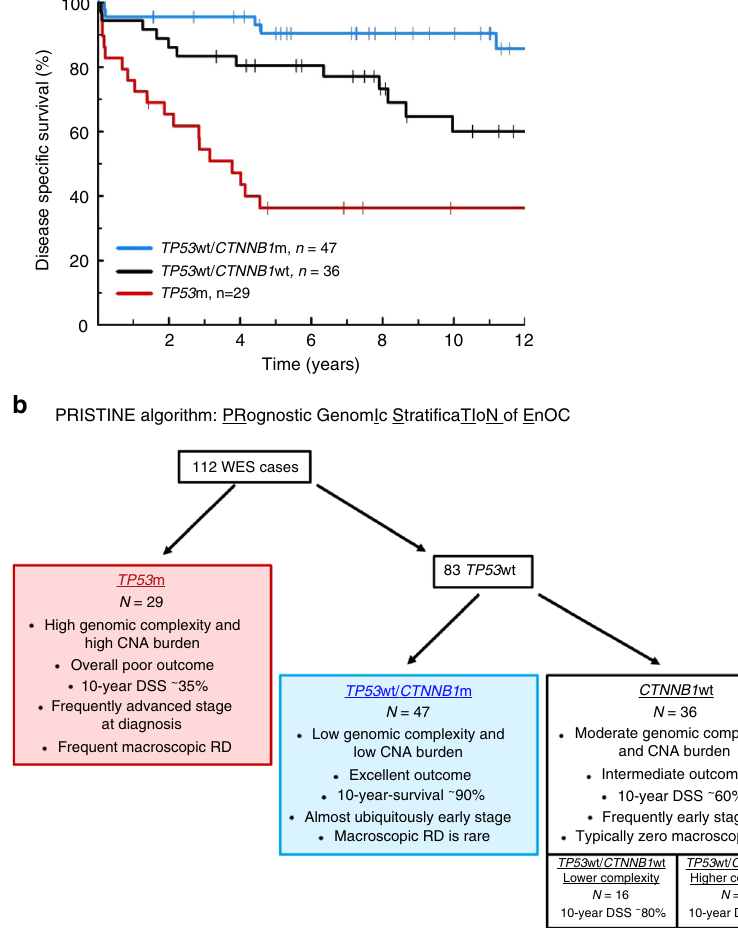
Fig. 5 Genomic subtypes of endometrioid ovarian carcinoma demonstrate distinct clinical behaviour. a Disease-speci fi c survival based on TP53 m and CTNNB1 m status; labelled hazard ratio represents comparison of the TP53 wt/ CTNNB1 m group with the TP53 m group. HR for TP53 wt/ CTNNB1 wt vs. TP53 m = 0.37, 95% CI 0.18 – 78; HR for TP53 wt/ CTNNB1 m vs. TP53 wt/ CTNNB1 wt = 0.31, 95% CI 0.11 – 0.88. b Summary of the PRISTINE algorithm for molecular subtyping in endometrioid ovarian carcinoma. m mutant, wt wild-type, RD residual disease, WES whole exome sequencing, DSS disease-speci fi c